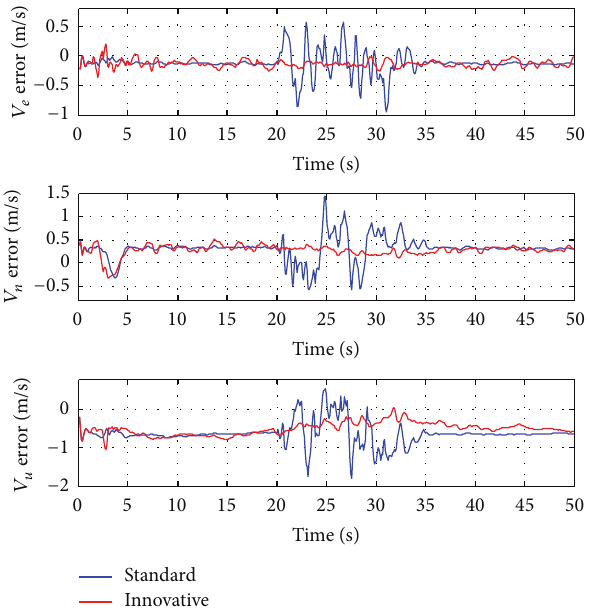
Figure 12: Velocity error